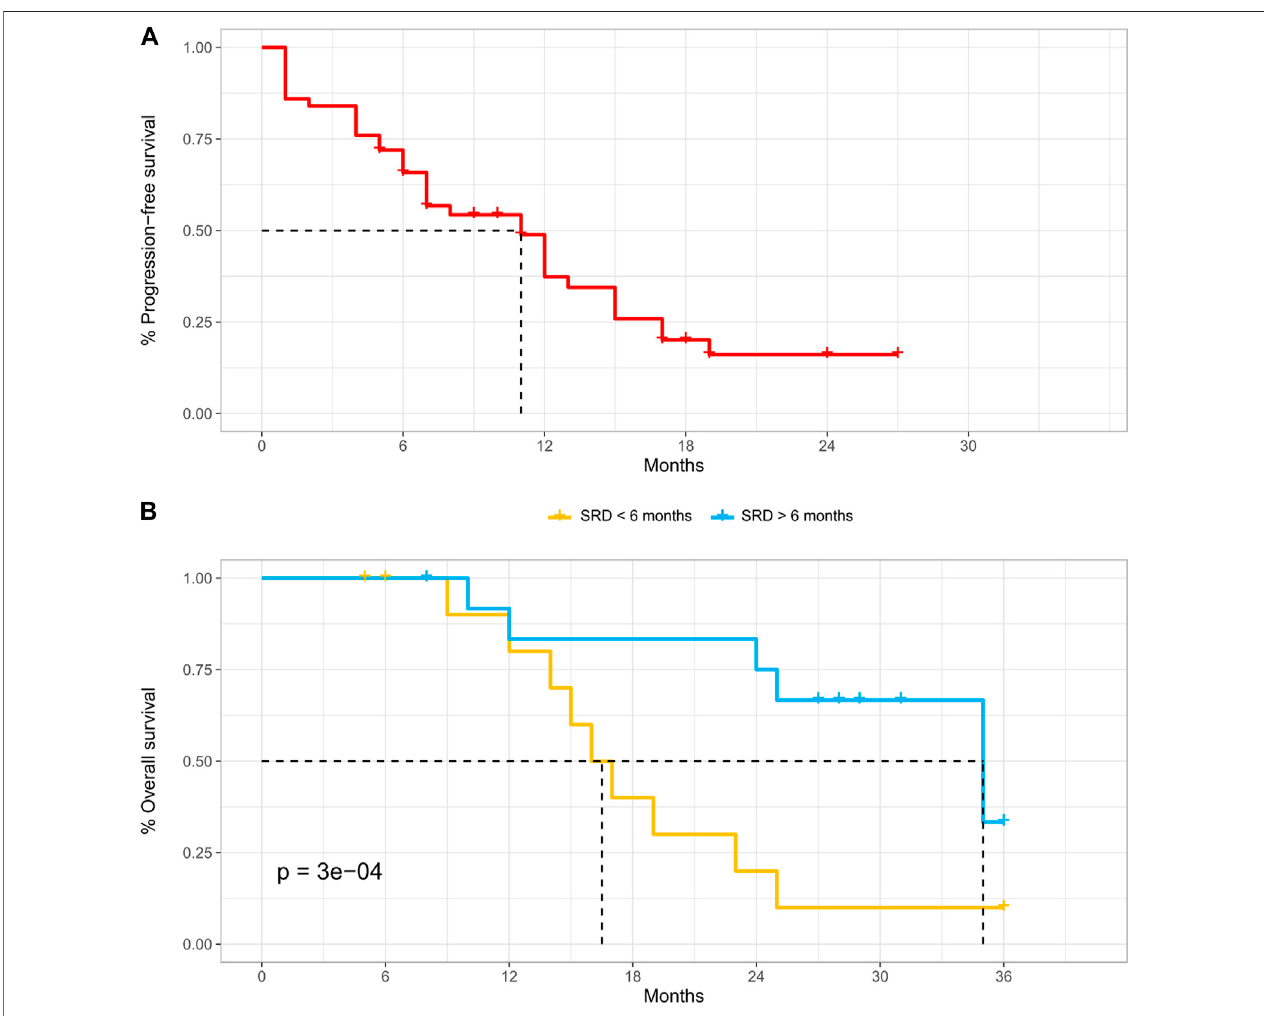
FIGURE 2 | (A – B) Time-to-event analysis (listing to progression) (A) and time-to-event analysis (listing to death), according to sustained response duration (SRD) (B)